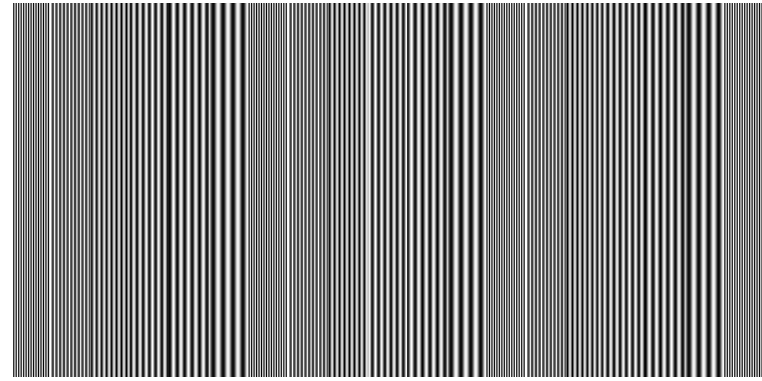
Figure 11. Designed fringe pattern that gives the fringe order information.